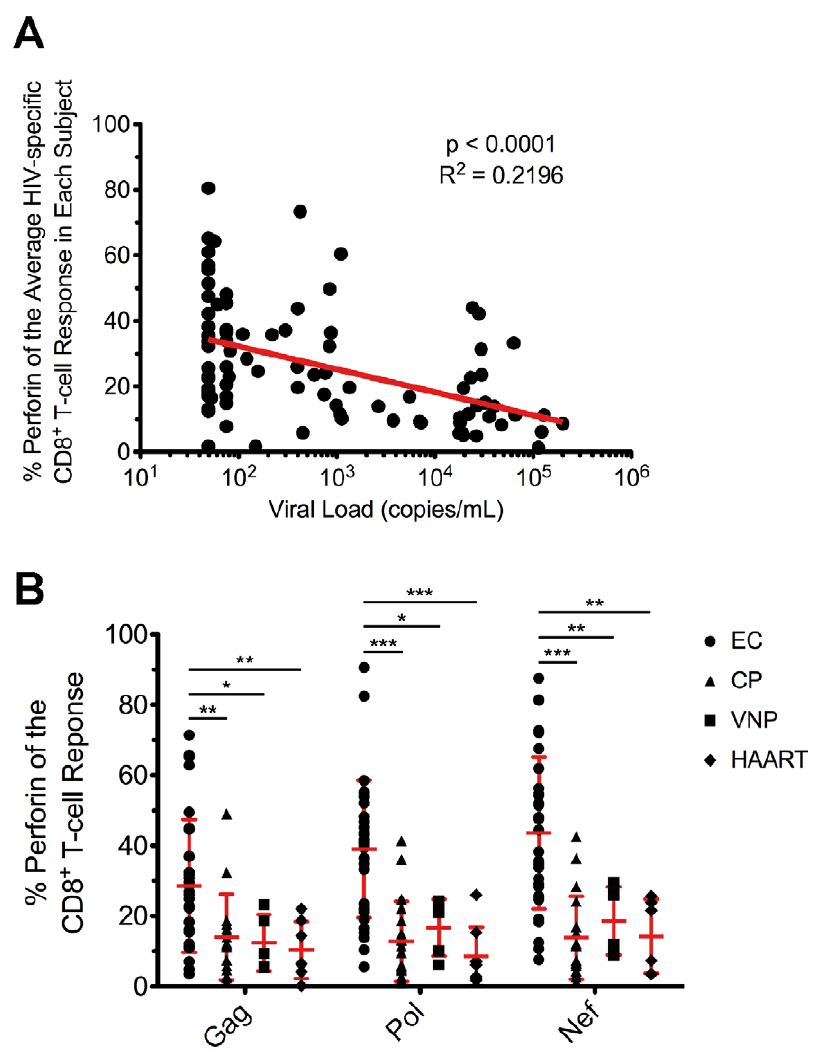
Figure 5. Inverse relationship between viral load and HIV-specific perforin expression, which is not rescued by HAART. (A) The average proportion of HIV-specific perforin expression within each subject was plotted against the HIV viral load from each respective subject. The most proximal viral load measurement to the time point of the PBMC sample was used in the analysis. Spearman correlation tests (nonparametric; two-tailed) were performed to determine statistical significance. (B) The relative contribution of perforin to the Gag-, Pol-, and Nef-specific CD8 + T-cell responses is shown for all EC, CP, VNP, and HAART-suppressed subjects. Each symbol represents an individual study subject. One-way ANOVA tests (nonparametric; Kruskal-Wallis test) were performed followed by a Dunns test for multiple comparisons. * denotes a p value , 0.05, ** denotes a p value , 0.01, and *** denotes a p value , 0.001. The error bars represent the mean and standard deviation.